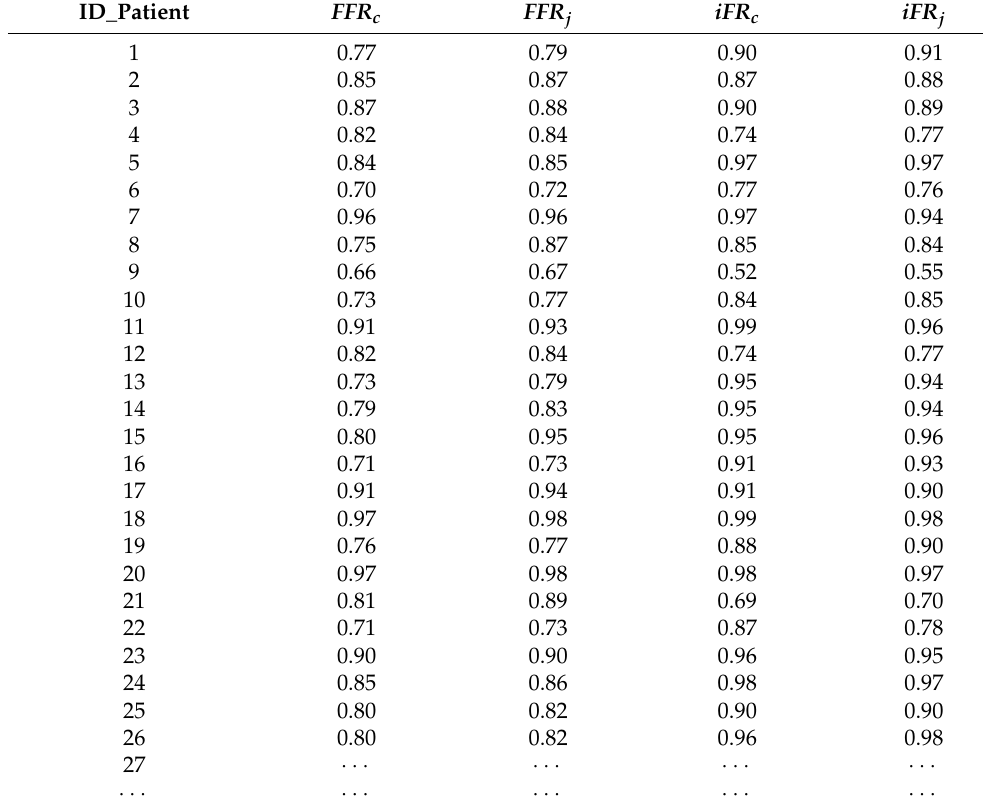
Table 1. FFR and iFR values extracted by commercial software ( FFR c , iFR c ) and JLabChart ( FFR j , iFR j